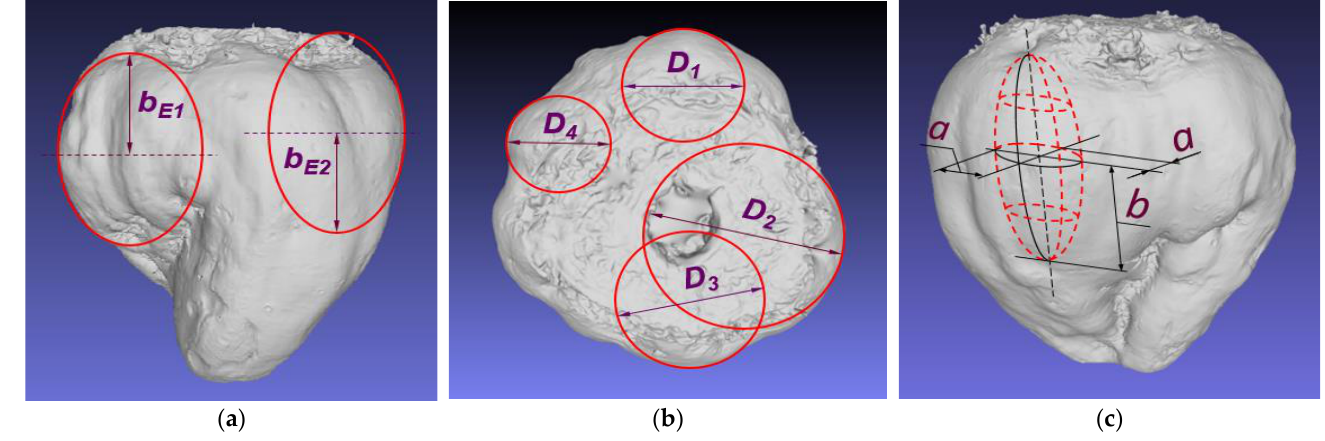
Figure 2. Three-dimensional scans of the sugar beet. ( a ) View in the plane parallel to the main axis with large half-axes ( b E 1 , b E 2 ) of the ellipses describing the vertical root curvatures; ( b ) view in the plane perpendicular to the main axis and diameters ( D 1 – D 4 ); ( c ) local beet surface curvatures mod- elled by the prolate ellipsoid of the dimensions; half-axes — small a and large b